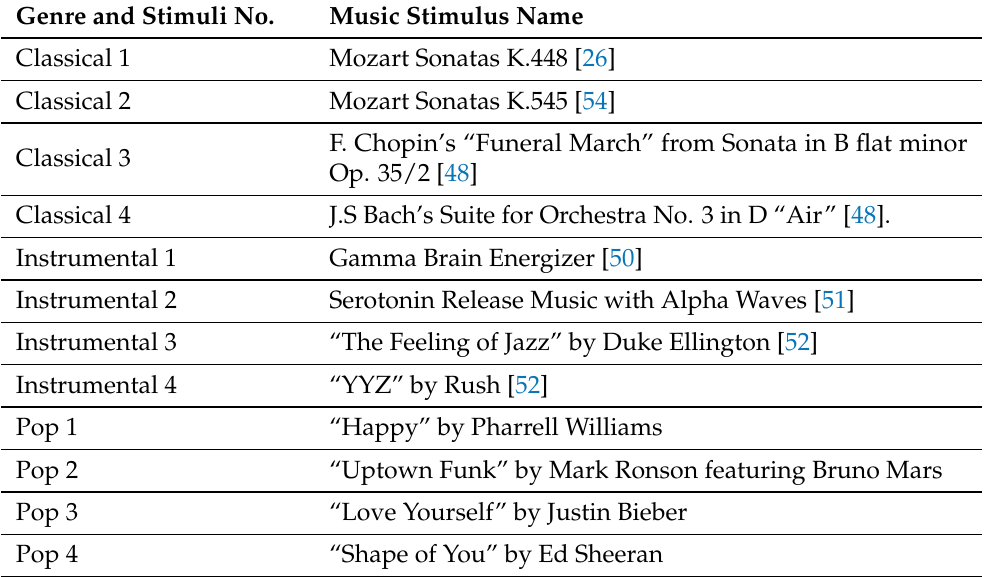
Table 1. Music Stimuli Used in the Experiment. Genre and Stimuli